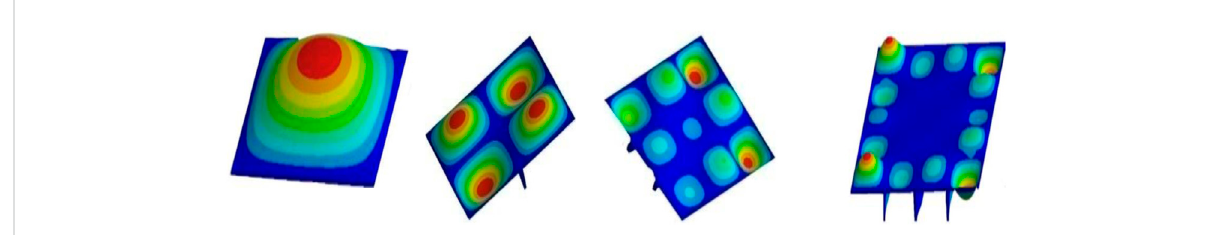
FIGURE 3 First modal vibration mode shapes for the intact and the stiffened square plates.